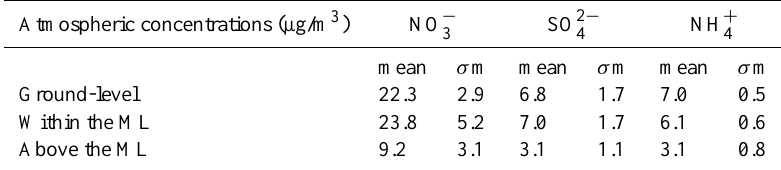
, SO 2 − and NH + measured along vertical profiles. Concentrations measured above the 3 4 4